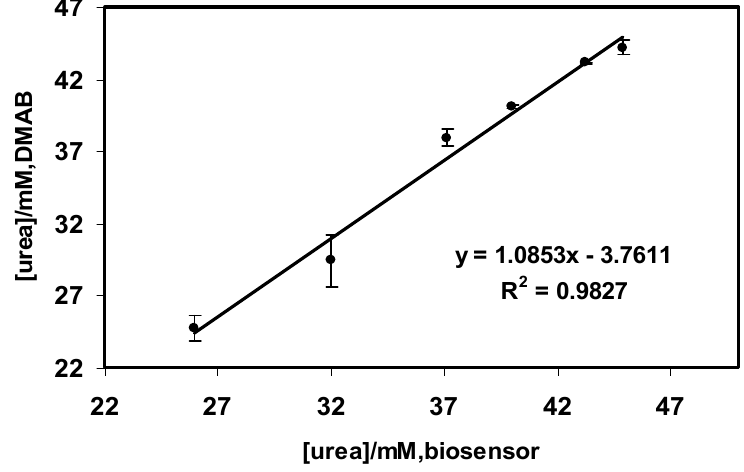
Figure 4. The relationship between spiked urea concentrations in urine samples determined by biosensor method and DMAB